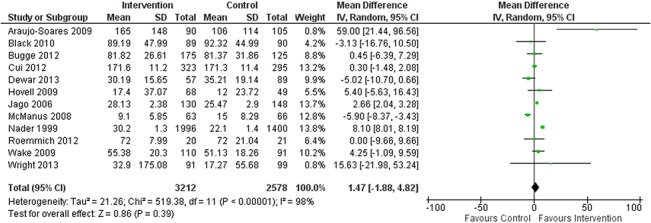
Forest Plot of Mean Difference in Change in MVPA between Intervention (n = 3212) and Control (n = 2578).Groups across the 12 included studies reporting MVPA data.